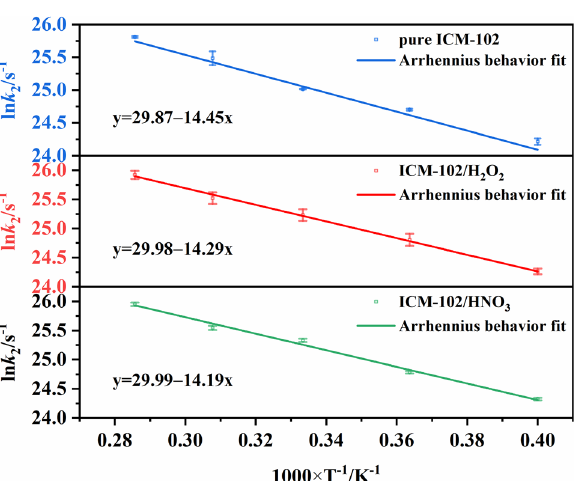
Figure 10. Logarithm of k 2 plotted against the inverse temperature (1/ T ) at 2500, 2750, 3000, 3250, and 3500 K.